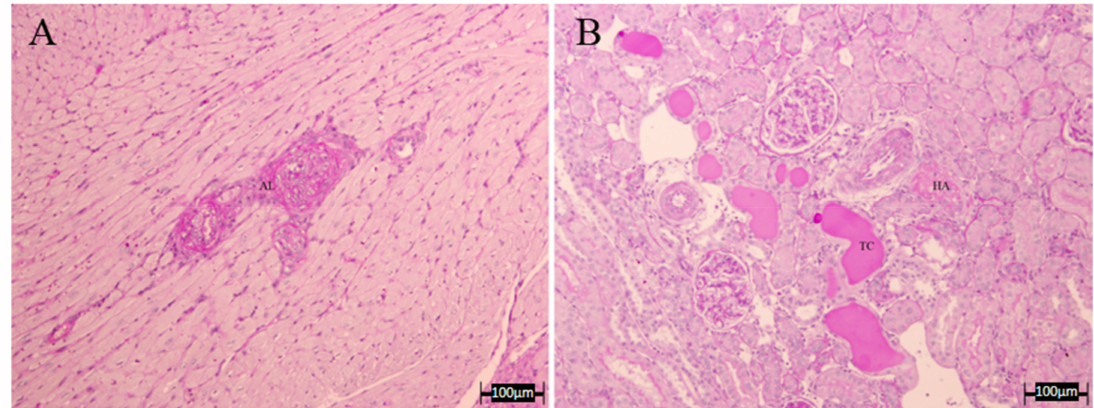
Figure 8. Representative microphotographs of heart and kidney lesion in the Apigenin group. ( A ) Less arterial and muscular injury (PAS 10 × ); ( B ) tubular cast and mild hyaline arteriopathy without fibrinoid necrosis in renal tissue (PAS, 10 ×